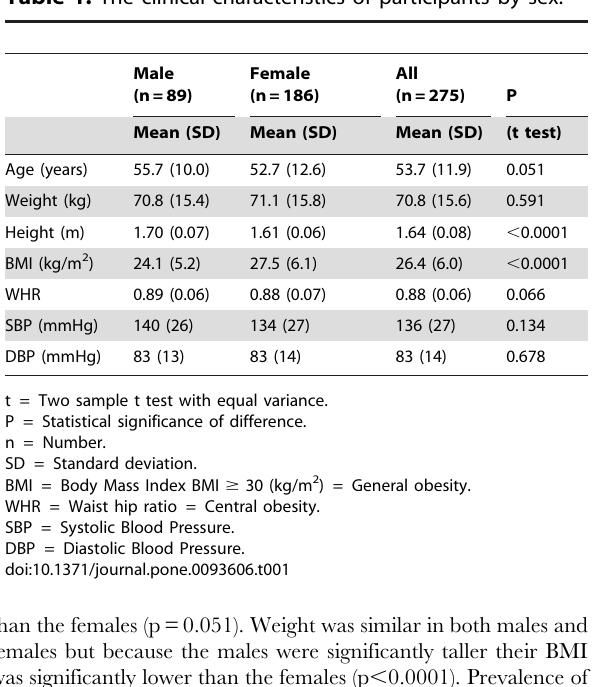
Table 2. The clinical characteristics of participants by sex.